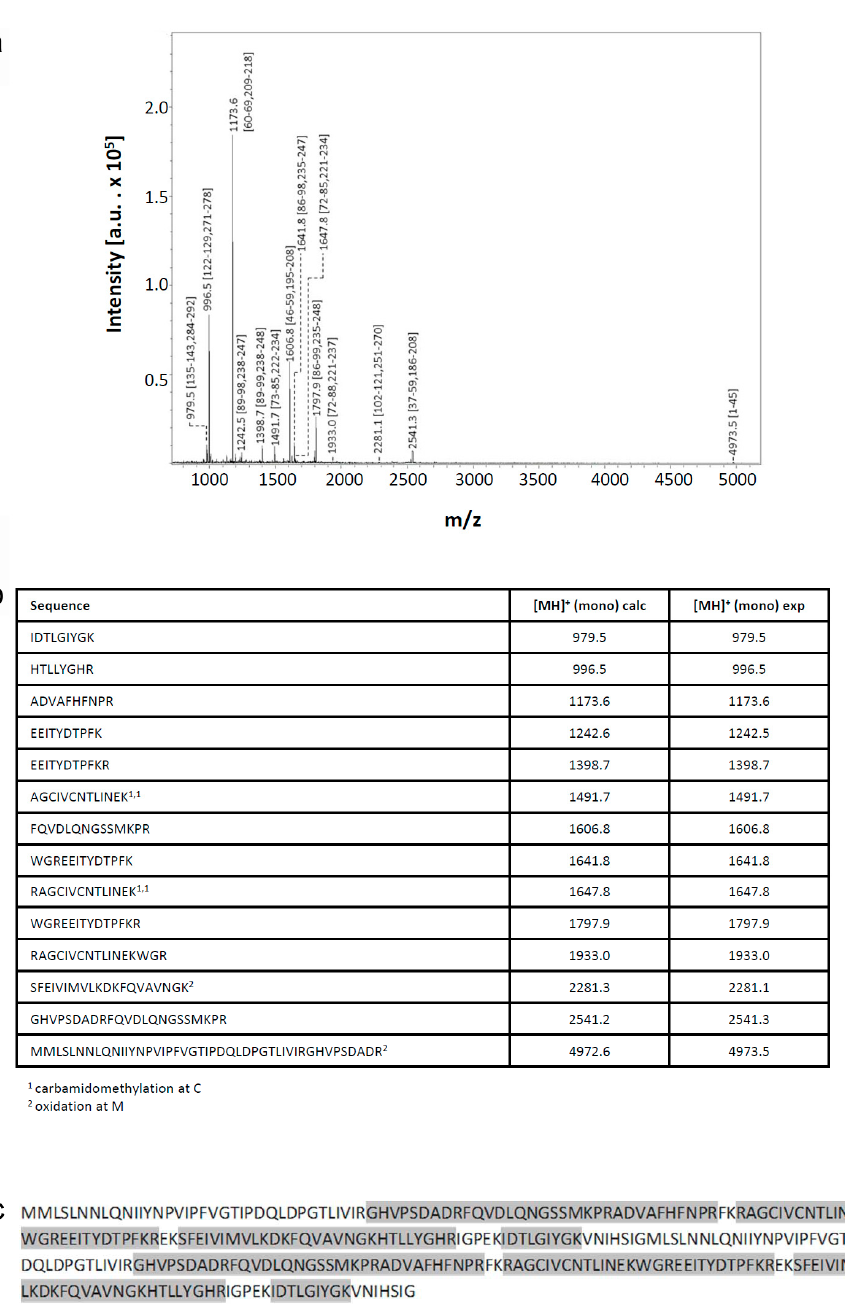
Figure 3. Mass spectrometric fingerprinting of peptides obtained by treatment of Gal-8 (NN) with trypsin. ( a ) The annotated spectrum; ( b ) the list of detected peptides with their calculated (calc) and experimentally (exp) measured mass values and ( c ) the sequence coverage are shown.